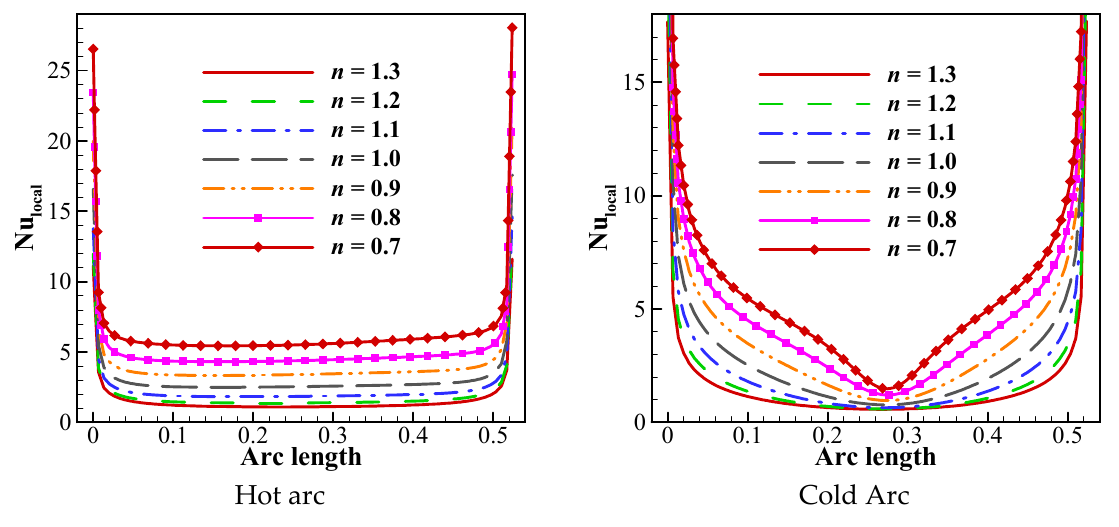
Figure 6. Dependence of the local Nusselt number, Nu loc , along the hot and cold surface for different values of n when Ra T = 10 4 , Ra M = 10 7 , Pr = 100, Ma = 10 − 4 , β c = 60, L = 0.3 and λ = π